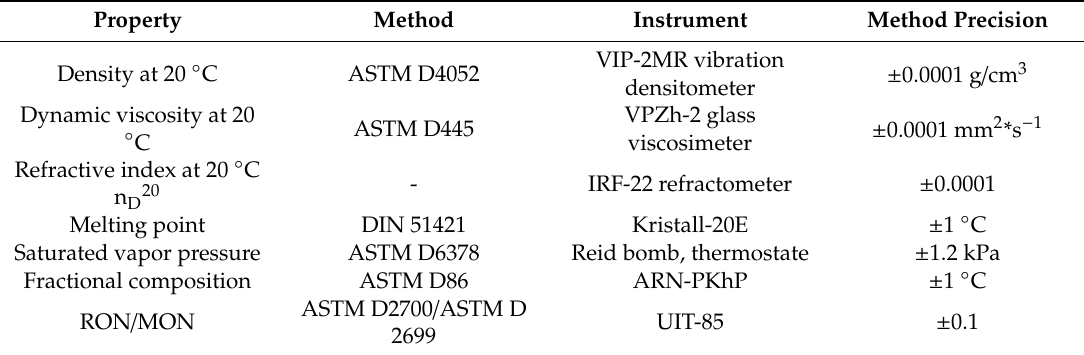
Table 16. The methods used for the diol derivatives